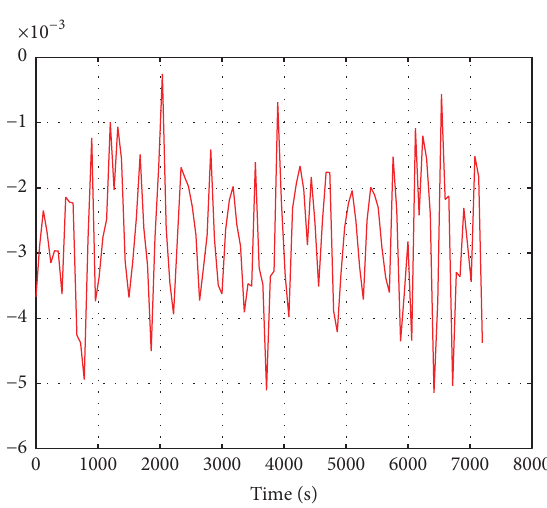
Figure 9: The variation of coverage rate difference when division granularity is 0.1 ∘ .